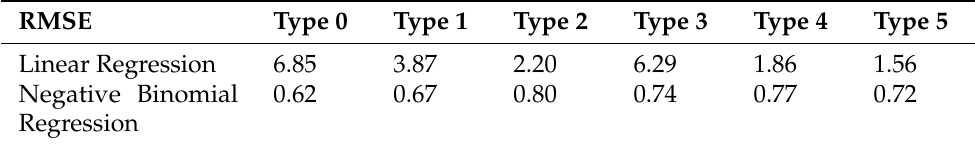
Table 5. Root Mean Square Error Values of Regression Algorithms for